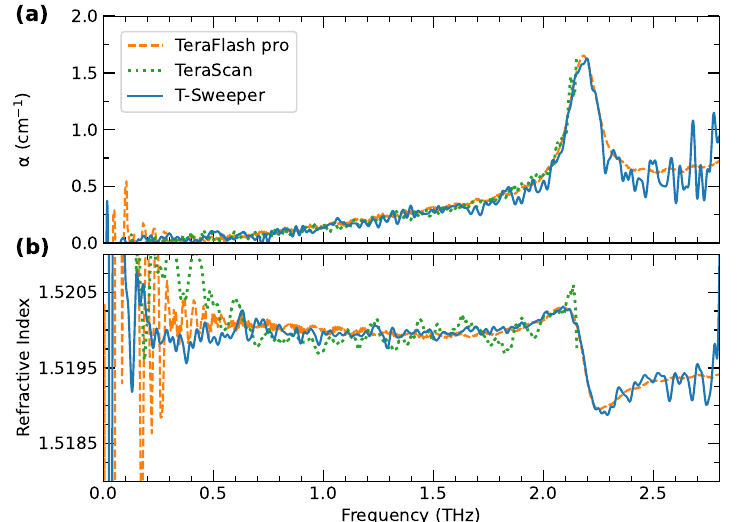
Figure 8. Absorption coefficient ( a ) and refractive index ( b ) of UHMWPE measured by TeraFlash, T-Sweeper, and the TeraScan. The narrow range of values measured reveals the noise in the ex- tracted